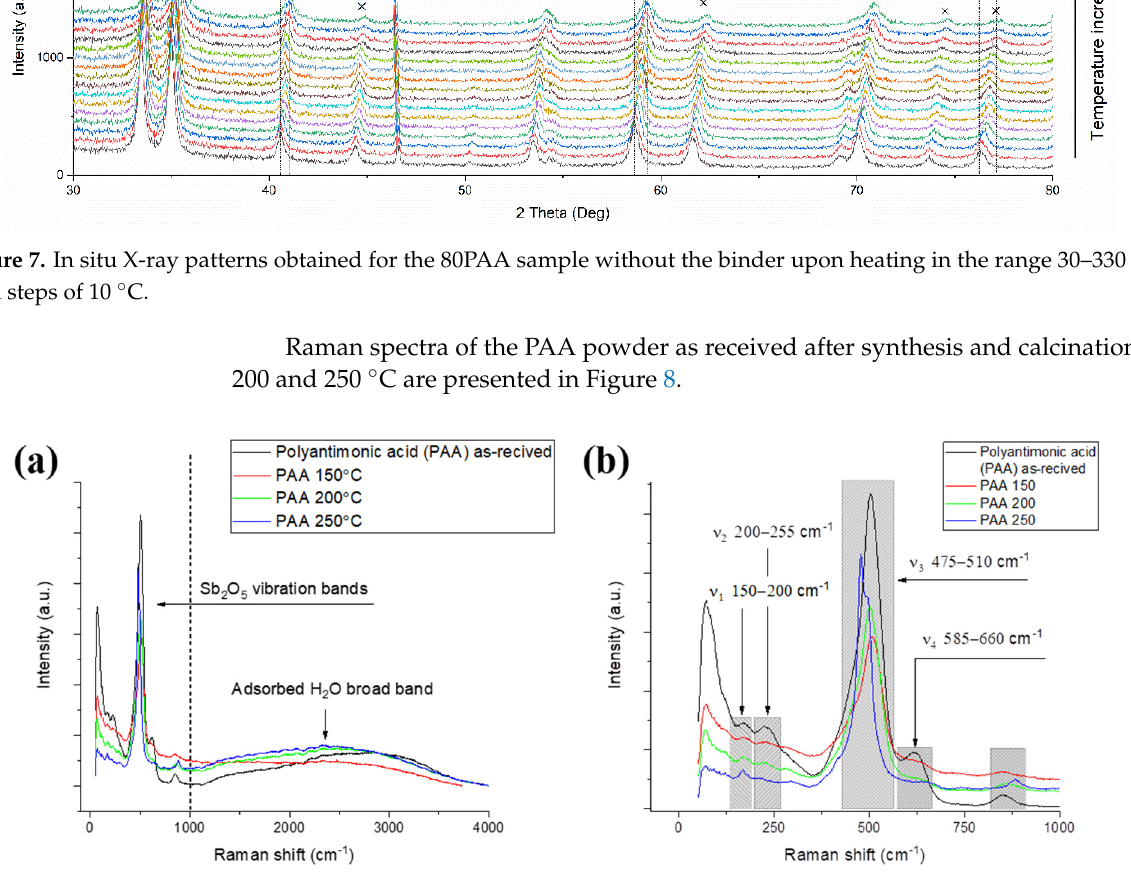
Figure 8. ( a ) Raman spectra of as-received PAA and after calcination at 150–250 °C; ( b ) detailed area of Sb 2 O 5 vibration bands.